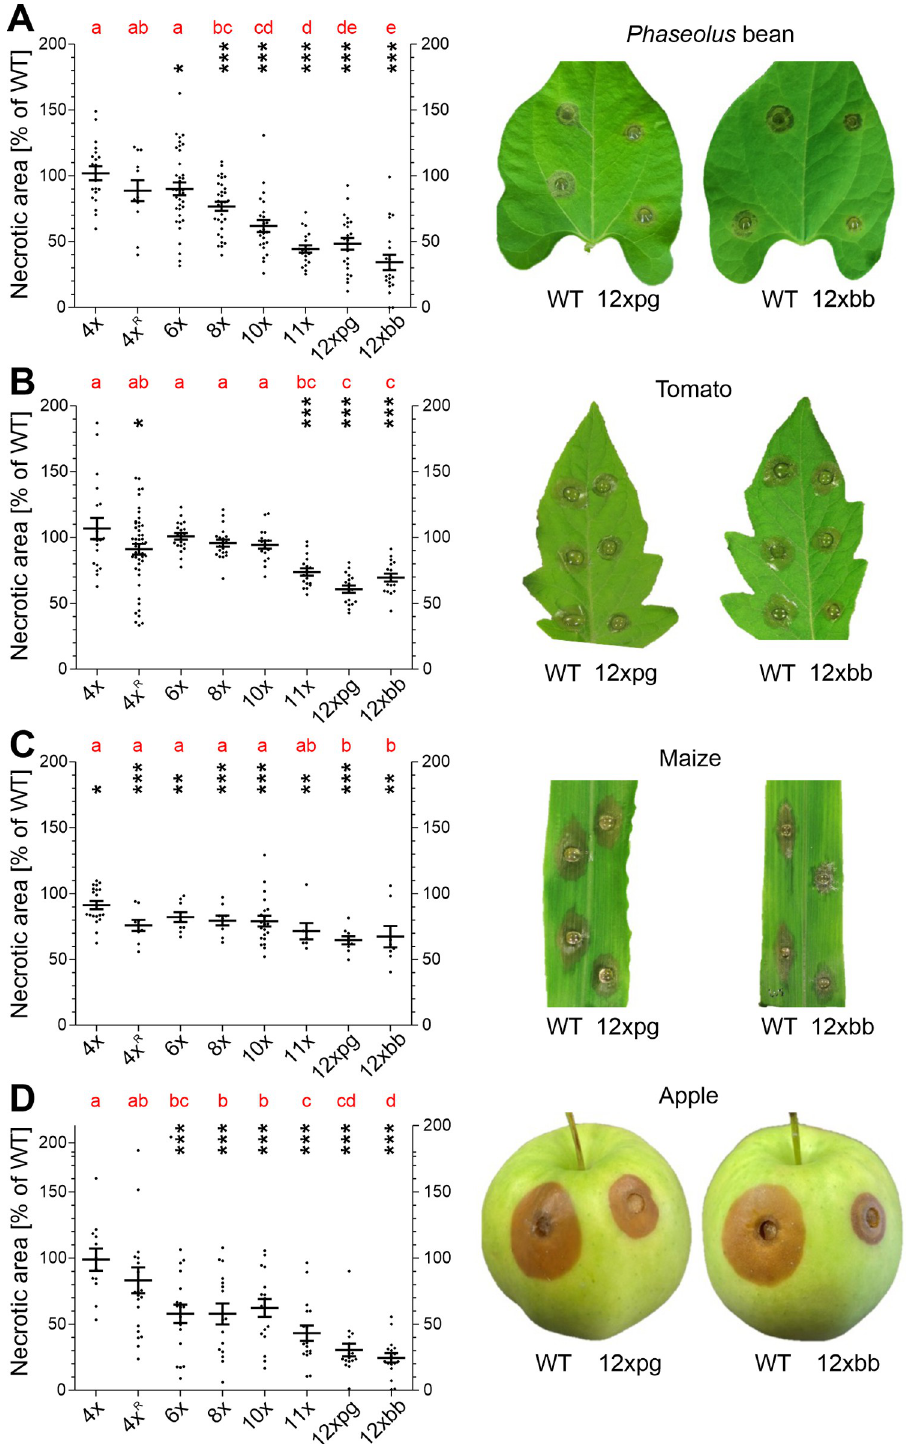
Fig 3. Infection tests of multiple CDIP/ phytotoxin mutants on different host tissues. A: Attached Phaseolus bean leaves (48 h.p.i.). B: Detached tomato leaves (48 h.p.i.). C: Detached maize leaves (72 h.p.i.). D: Apple fruits (96 h.p.i.). The p values by one-sample t test to a hypothetical value of 100% (WT) are shown, indicating significant reductions of the mutants compared to WT lesions. � p < 0.05; �� p < 0.01; ��� p < 0.001. For comparison of the mutants, results of a one-way ANOVA and Tukey’s post hoc test are displayed with compact letter display. The pictures show lesions caused by 12xbb and 12xpg mutants in comparison to WT. https://doi.org/10.1371/journal.ppat.1010367.g003 PLOS Pathogens| https://doi.org/10.1371/journal.ppat.1010367 March 3,